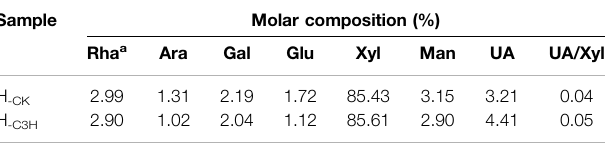
TABLE 1 | Composition analysis of CK and C3H. Sample